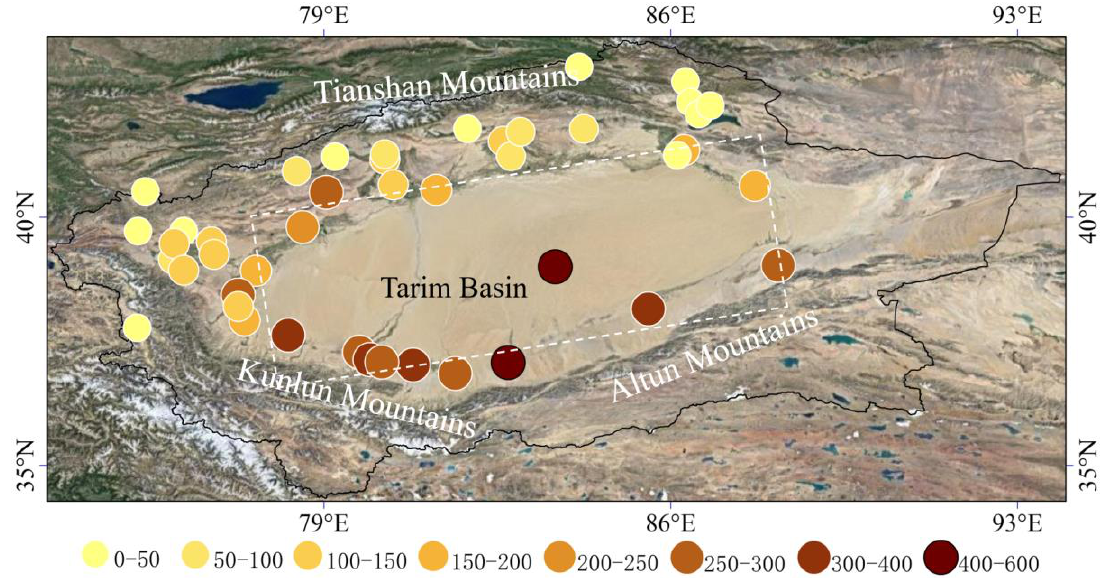
Figure 6. Spatial Distribution of DI in Tarim